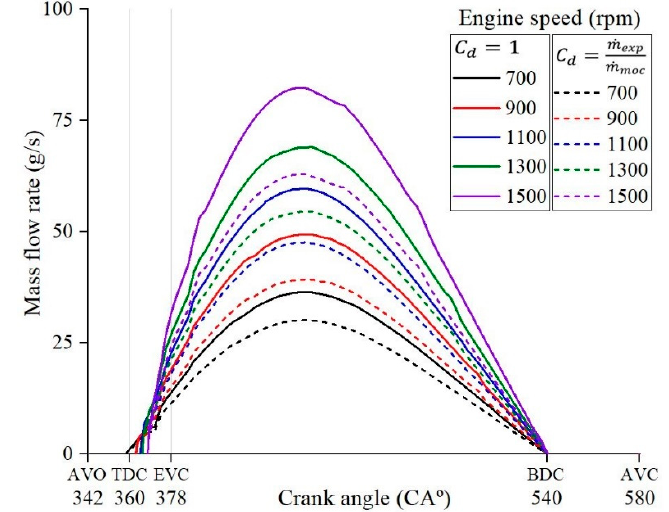
Figure 6. One-dimensional analysis results of the mass flow rate. AVC, air–intake valve closes; AVO, air–intake valve opens; BDC, bottom dead center; EVC, exhaust valve closes; TDC, top dead